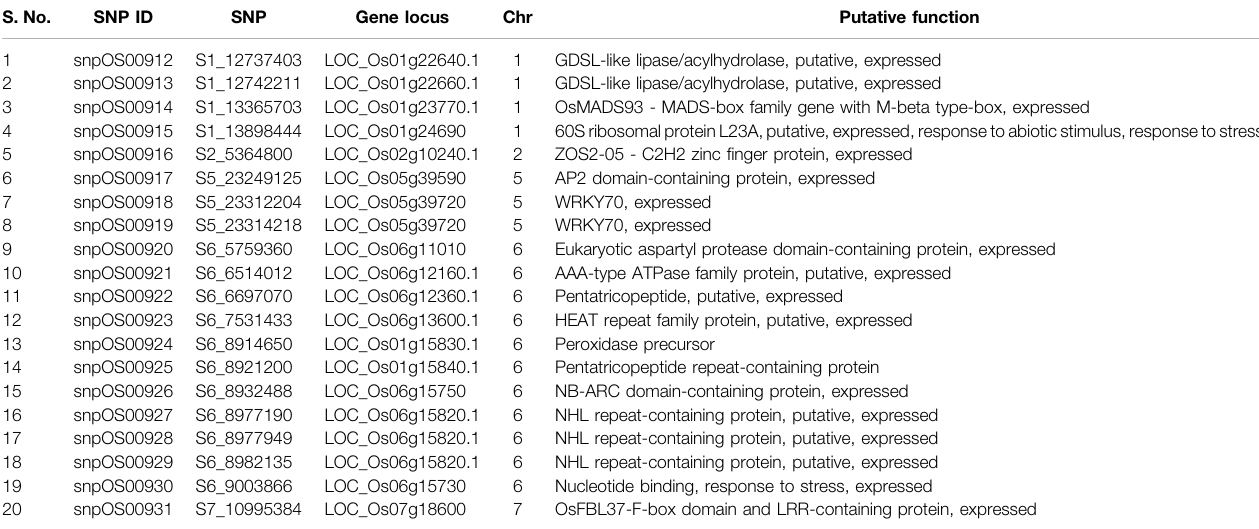
TABLE 6 | List of 20 SNPs selected from GLM and FarmCPU models. S.